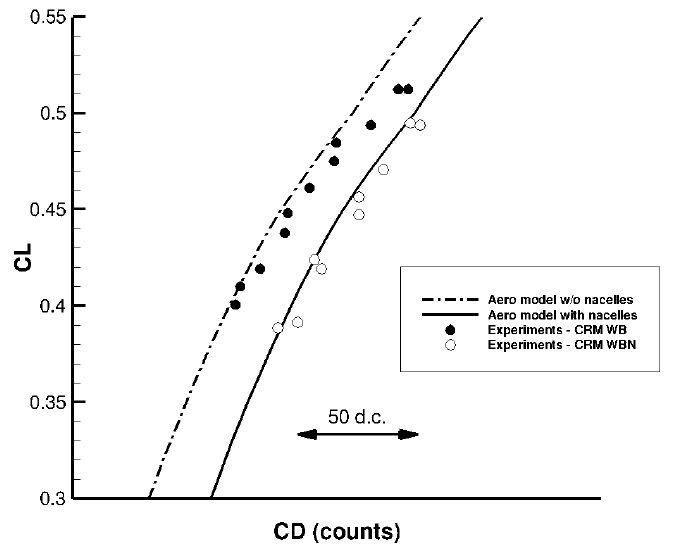
Figure 22. CRM configuration—Nacelle (TFN) effect. Lines—aerodynamic module; symbols— experiments.